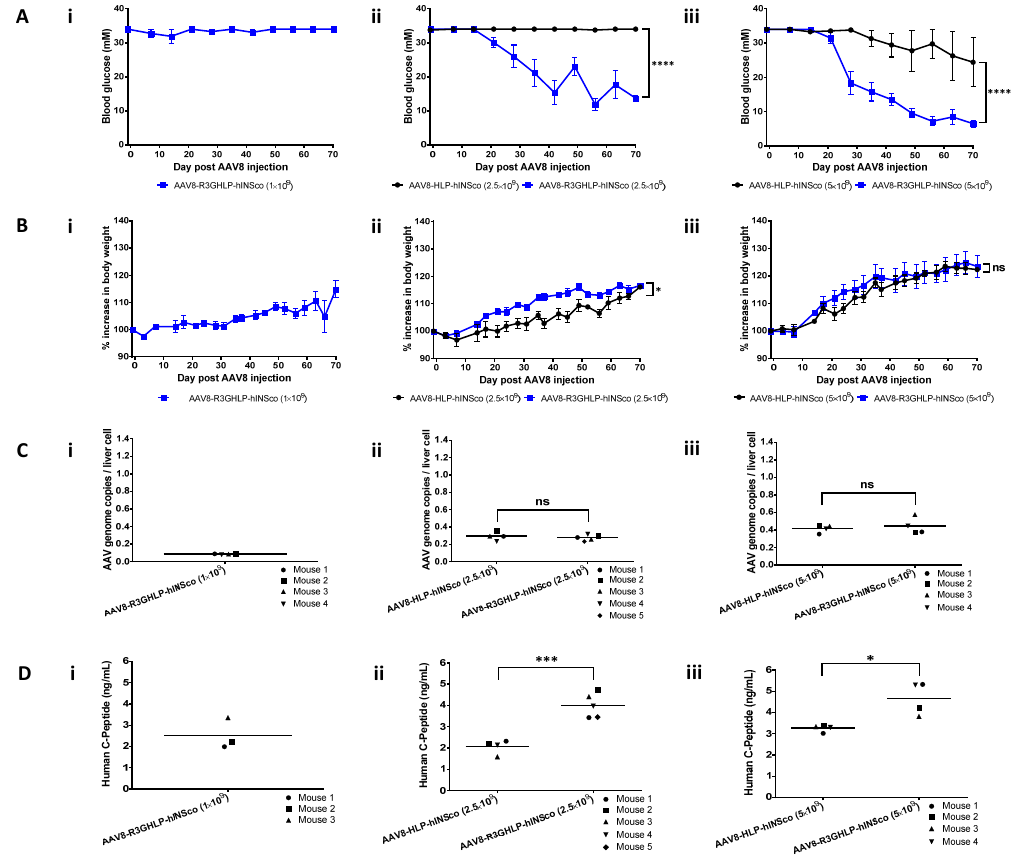
Figure 2. Treatment efficacy of AAV8-R3GHLP-hINSco on streptozotocin (STZ)-induced diabetic NOD.cg-PrkdcscidIl2rgtm1Wjl/SzJ (NSG) mice. Treatment efficacy of control non-glucose responsive adeno-associated virus serotype 8 (AAV8) vector, AAV8-HLP-hINSco and glucose responsive AAV8 vector, AAV8-R3GHLP-hINSco at ( i ) 1 × 10 9 (AAV8-R3GHLP-hINSco only), ( ii ) 2.5 × 10 9 and ( iii ) 5 × 10 9 vector genome per mouse (vg/mouse). ( Ai–iii ) Blood glucose level post AAV8 injection. ( Bi–iii )